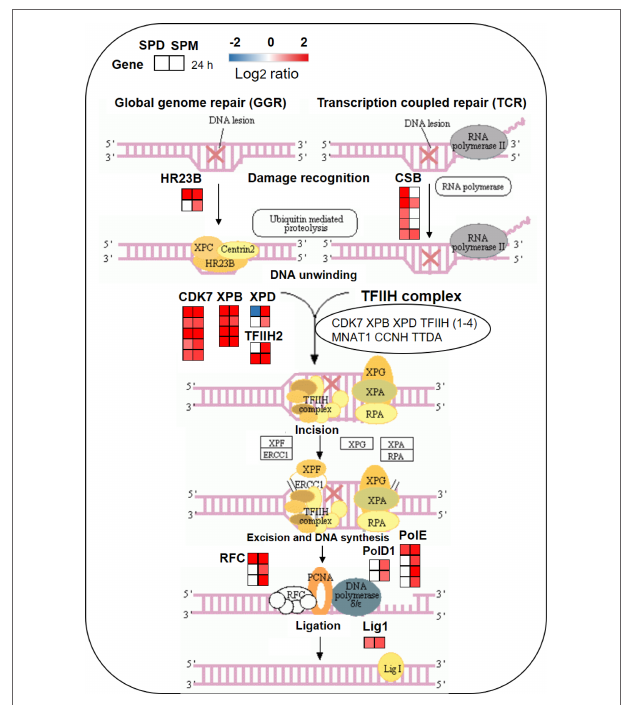
FIGURE 8 | PA-induced transcriptomic changes of DEGs in nucleotide excision repair under HT stress. For pathway analysis, each square represents the log2 FC level the corresponding DEG at 24 h, respectively. A red square indicates upregulation and a blue square indicates downregulation. The ratios of gene expression levels between the PA-treated and CK groups are listed in Supplementary Table S9